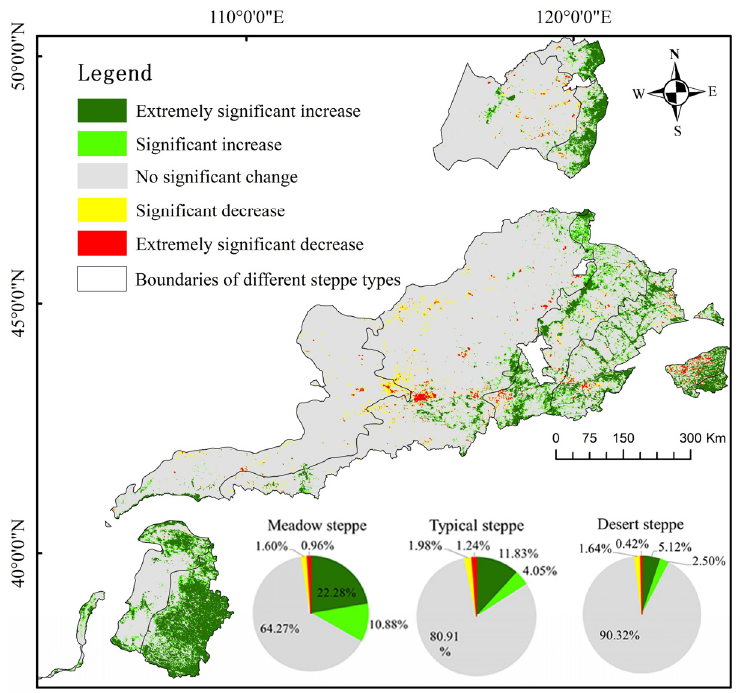
Figure 3. Normalized difference vegetation index (NDVI) changes for different steppe types of Inner Mongolia from 1998 to 2017, based on the interannual variation trend of the NDVI and its signifi- cance.